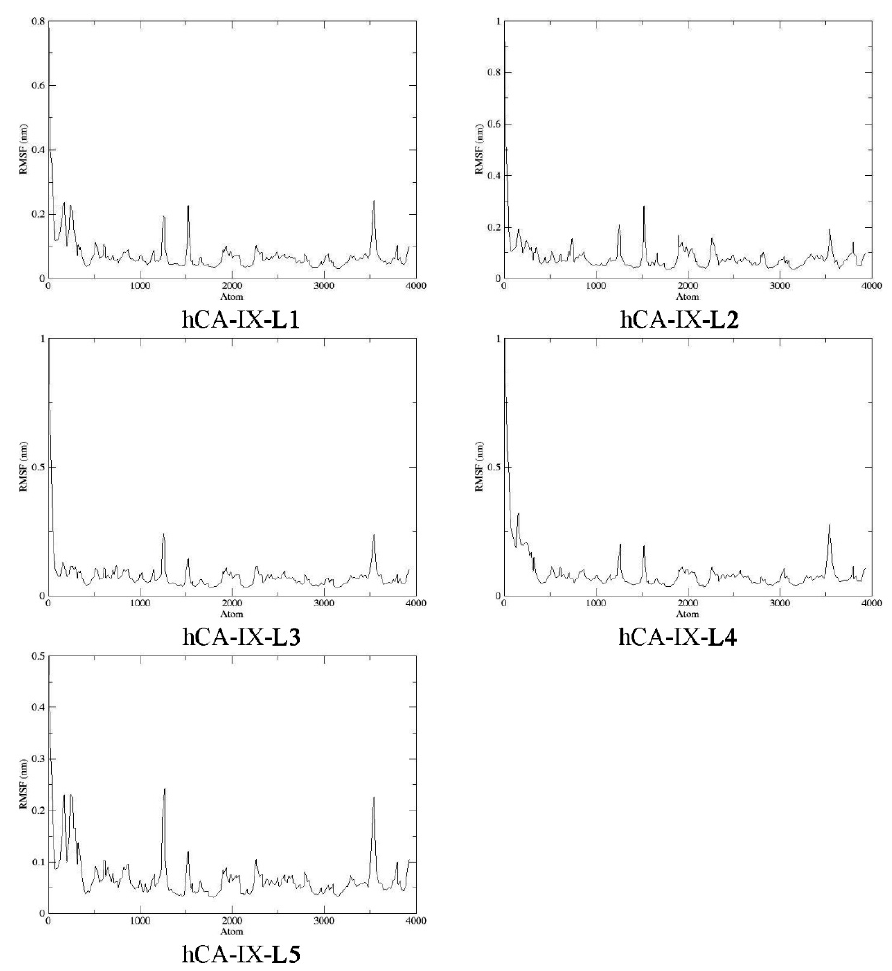
Figure 6. The root mean square fluctuation (RMSF) values of hCA-IX in complex with the investigated candidate compounds plotted against residue numbers.